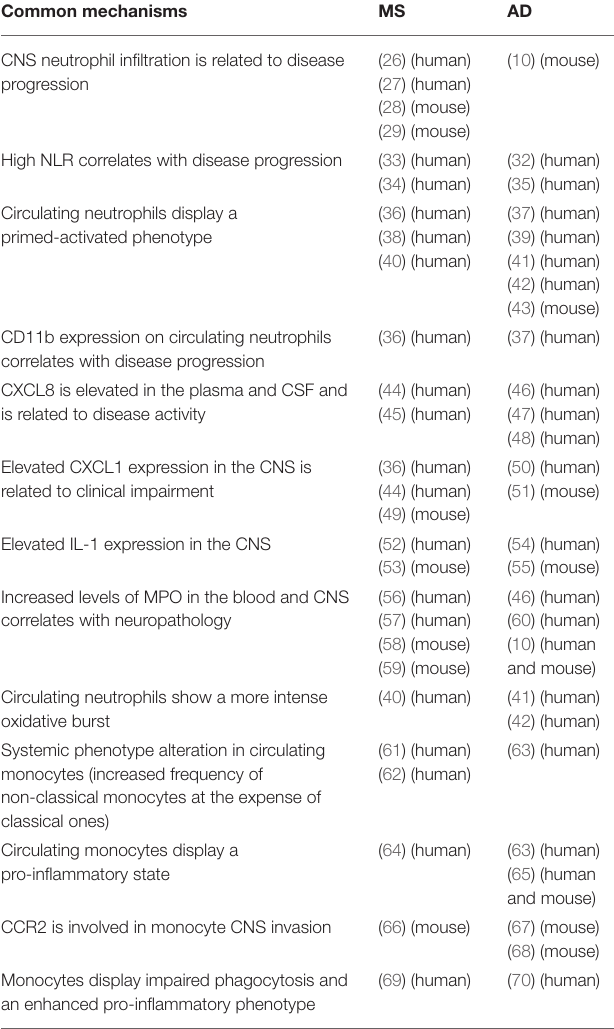
TABLE 1 | Summary of common pathways in the innate immune system during the development of MS and AD. Common